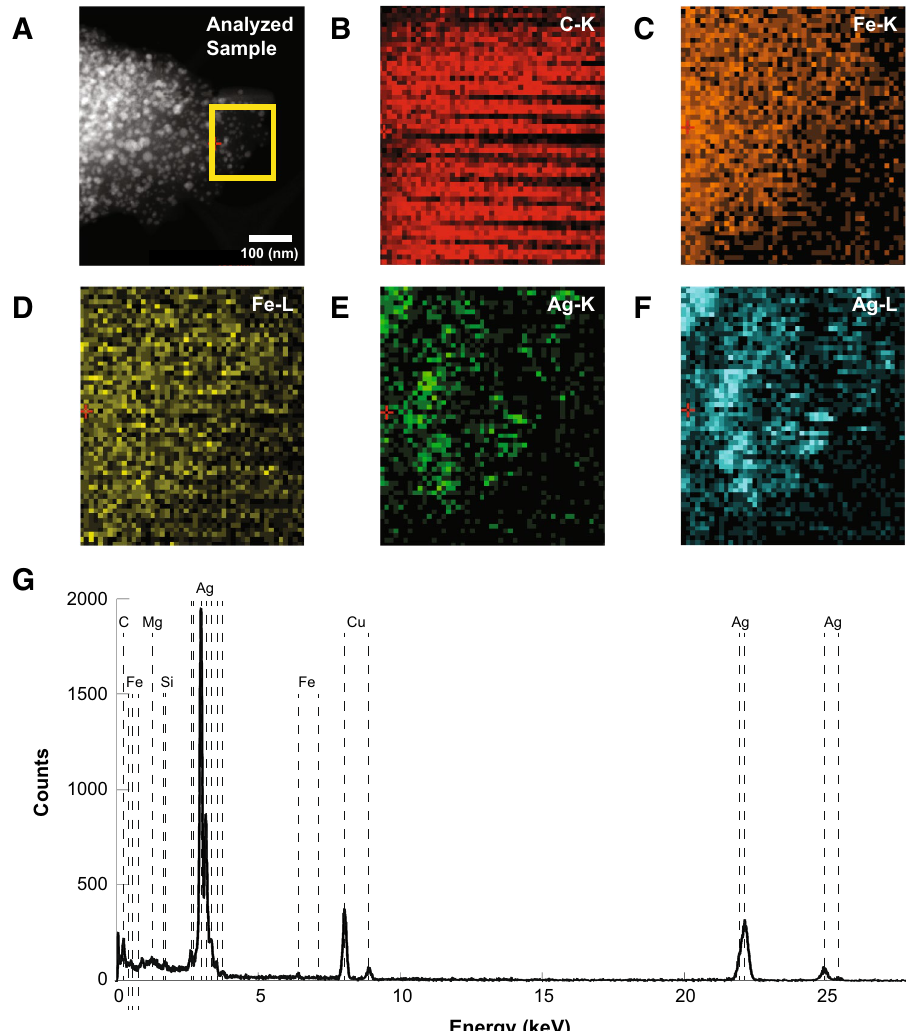
Figure 4. Darkfield image ( A )–( F ) and energy dispersive X-Ray (EDX) spectra (G) of Ag–Fe bimetallic nanoparticles synthesized using an aqueous extract from leaves of Gardenia jasminoides .